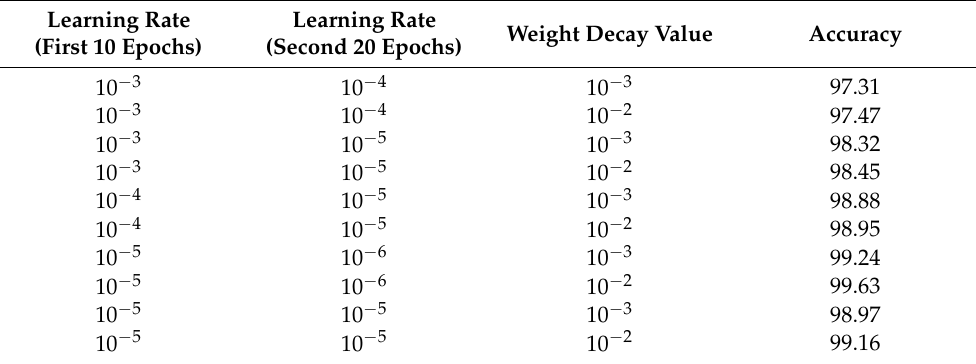
Table 1. The performance evaluation based on different learning rates in CNNs training process in terms of accuracy (%).